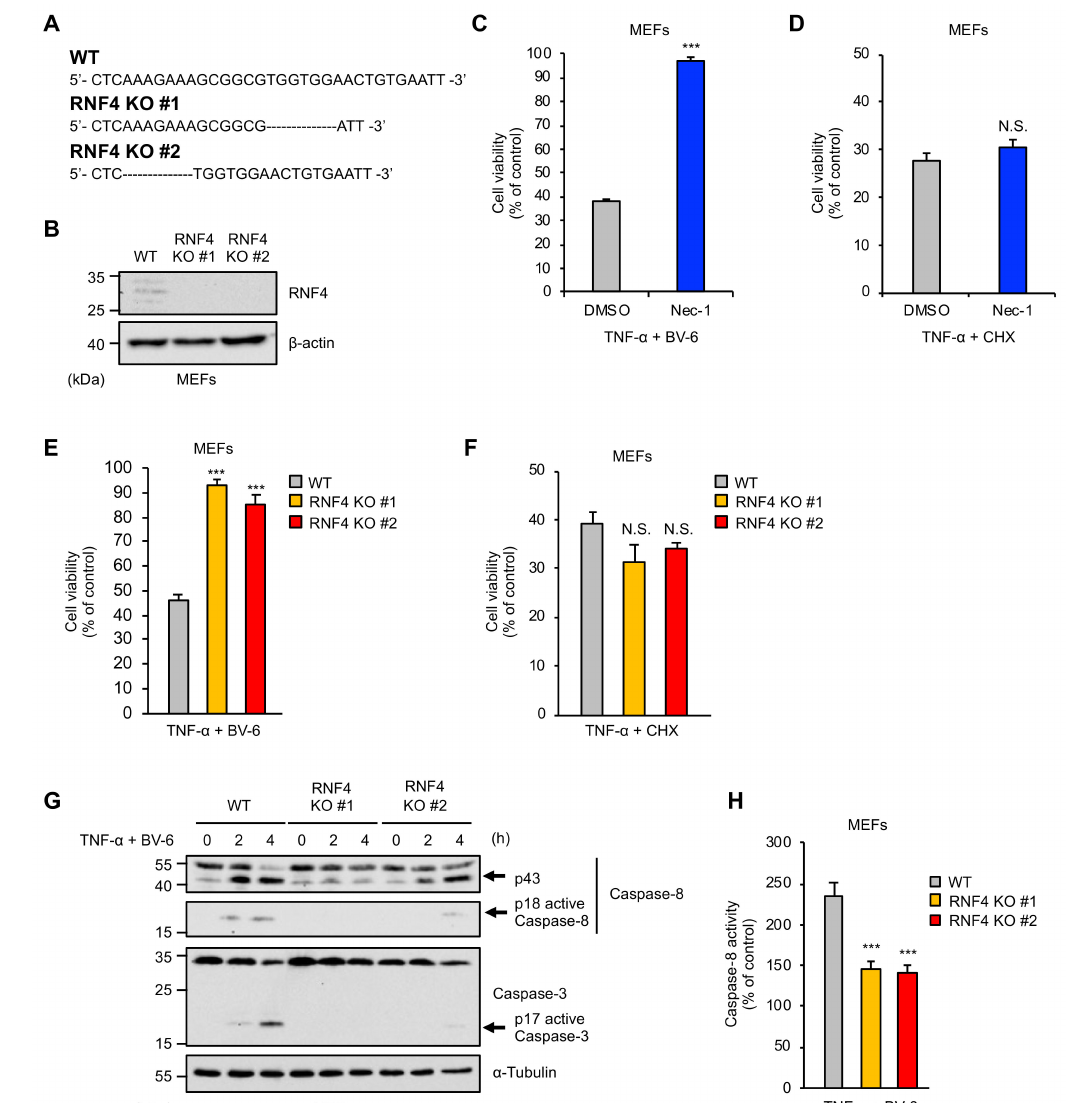
Figure 1. RNF4 is specifically required for RIPK1-mediated cell death stimulated by TNF- α . ( A ) DNA sequences around the guide RNAs (gRNAs) target sites of RNF4. ( B ) Immunoblot analysis of RNF4 in mouse embryonic fibroblasts (MEFs). MEFs were subjected to immunoblotting with the indicated antibodies. β -actin was used as a loading control. ( C , D ) Inhibitory effect of RIPK1 kinase inhibitor Nec-1 on TNF- α -induced cell death. ( C ) MEFs were treated with TNF- α (50 ng/mL) for 12